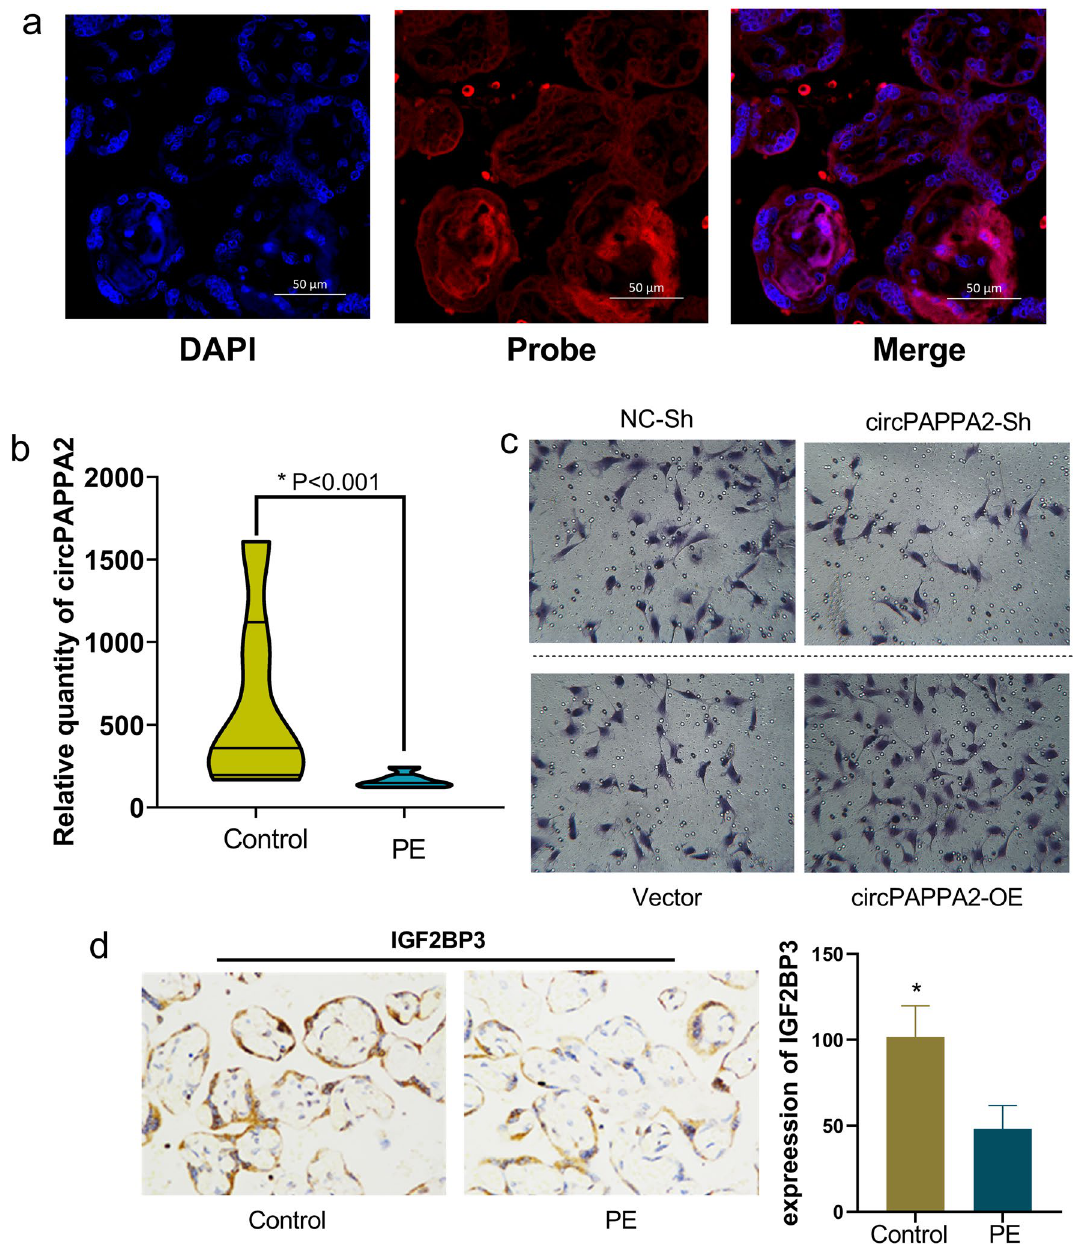
Figure 5. Fluorescent in situ hybridization assays showed that circPAPPA2 is located in the placenta ( a ). The expression of circPAPPA2 was increased in PE placentas compared to normal control placentas, as determined by RT-PCR (PE (n): control (n) = 6:6; P < 0.001) ( b ). Transwell invasion assays revealed that invasive capacity was significantly lower in the circPAPPA2 shRNA (circPAPPA2-sh) group than in the normal control shRNA (NC- Sh) group; the opposite result was obtained when circPAPPA2 was overexpressed (circPAPPA2-OE) ( P < 0.05). Collectively, the results indicate that circPAPPA2 may promote trophoblast invasion ( c ). Insulin-like growth factor 2 mRNA binding protein 3 ( IGF2BP3) was downregulated in PE placentas in the immunohistochemistry assay (* P < 0.05) ( d